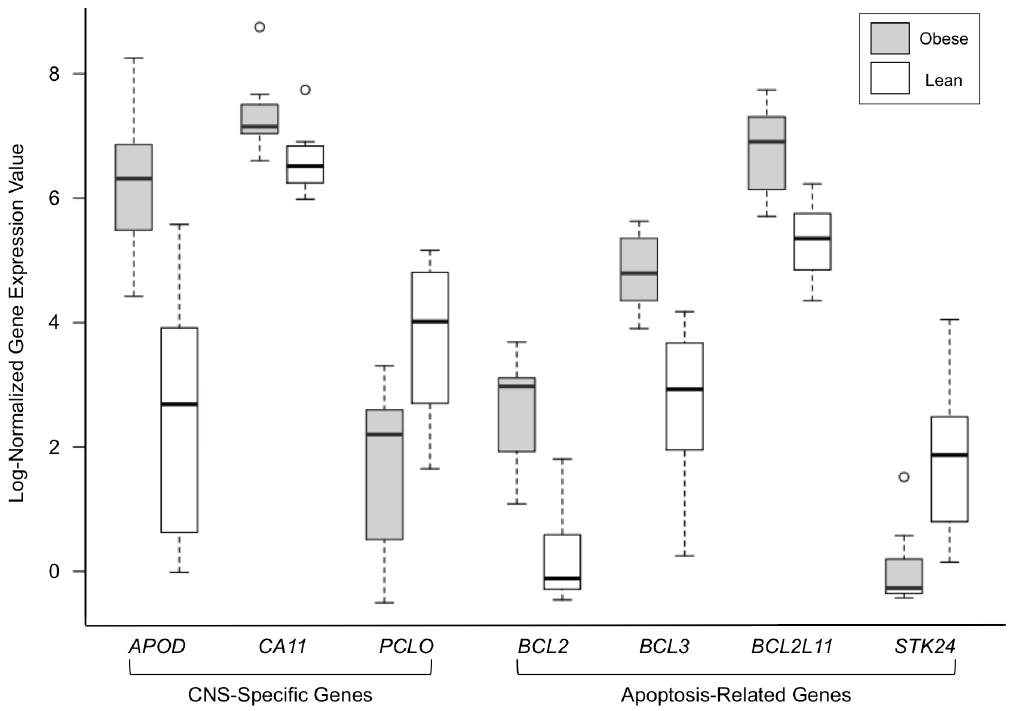
Figure 2. Central Nervous System-Specific and Apoptosis-Related Gene Expression Values in Obese versus Lean Subjects. Each box encompasses the interquartile range (IQR) of log-normalized gene expression values for the gene of interest in all obese (shaded box) and all lean (white box) subjects. The dark horizontal lines represent the median gene expression value for the obese or lean subjects. The whiskers represent values within 1.5 times the interquartile range greater than or less than the upper or lower quartile, respectively. The open circles represent values greater than 1.5 times the interquartile range.